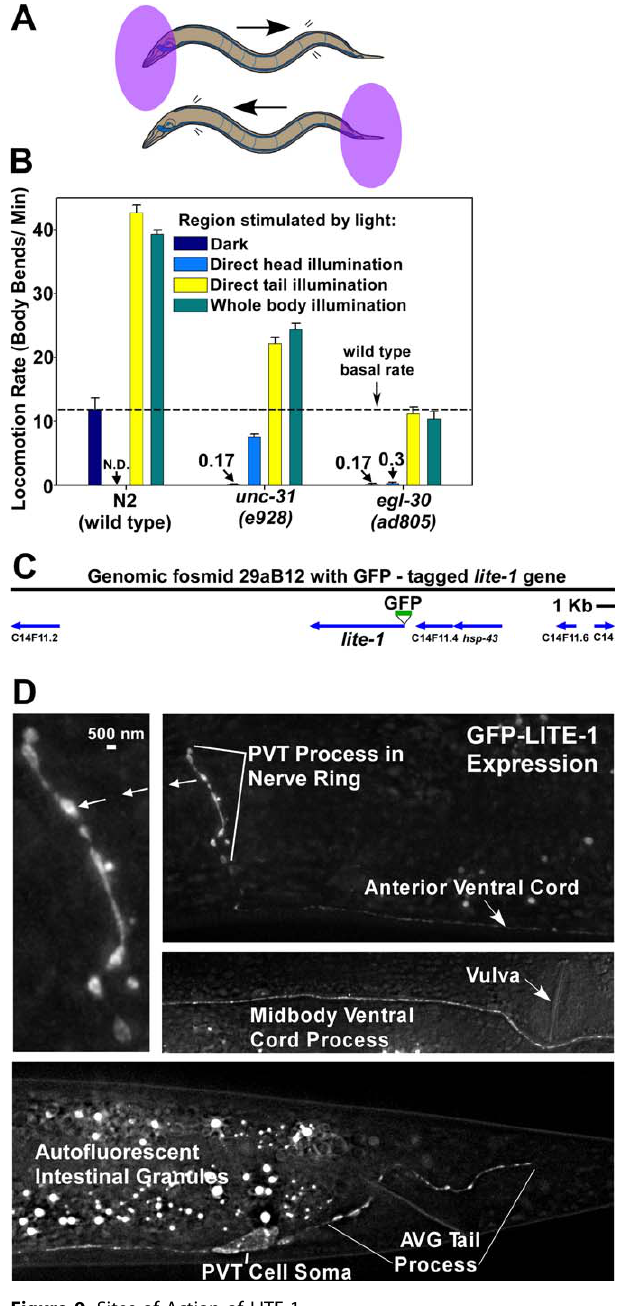
Figure 9. Sites of Action of LITE-1 (A) Drawings showing the areas illuminated in the regional illumination experiments. (B) Whole body or tail-only illumination rescues synaptic signaling mutants equally well. Numbers above some bars state the locomotion rates of near-paralyzed mutants. We did not assay N2 (wild type) for head illumination due to difficulty in maintaining head only illumination during the assay. Error bars are the standard errors in populations of 10 animals (whole body), 30 animals ( egl-30 – head and all tail light assays; 1 min each), or 60 animals ( unc-31 – head light assay; 30 s each). (C) Scale drawing shows the GFP-tagged genomic fosmid we used to make the GFP-LITE-1 transgenic strain ceIs51 . Arrows show gene locations and directions of transcription. (D) The LITE-1 receptor is expressed in only two neurons and concentrates in single head and tail processes. Images are from a lite-1 null mutant containing the ceIs51 transgene. GFP-LITE-1 is only detectable in the soma and process of the PVT neuron as well as the tail process (but not the soma) of the AVG neuron. The blobby